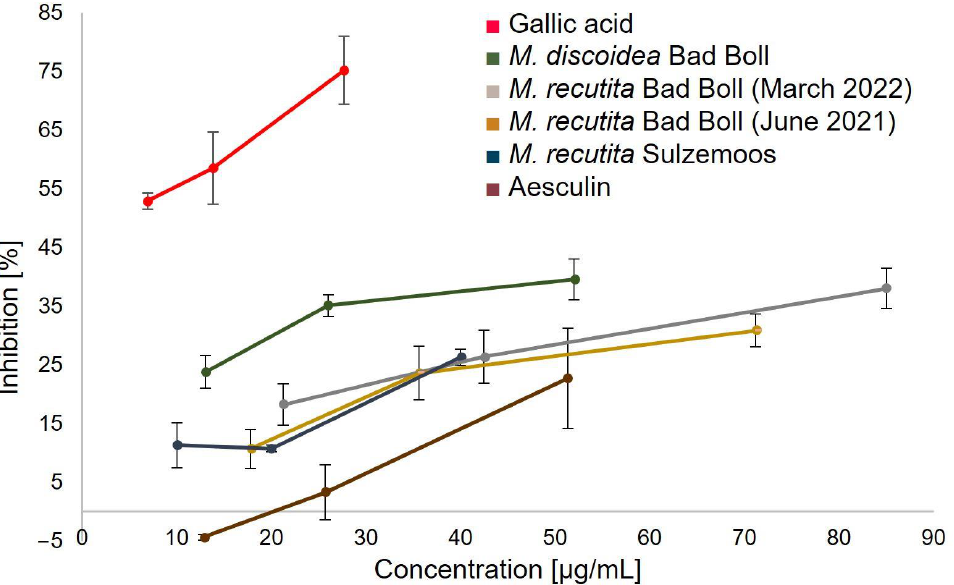
Figure 8. Superoxide anion radical scavenging activity of various chamomile root butanol extracts, aesculin and gallic acid. Results represent mean ± SD ( n = 3). Negative inhibition values result from mathematical calculation of the relative inhibition.